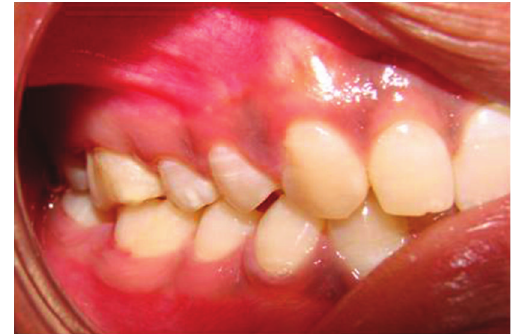
Figure 29: Intraoral periapical radiograph with upper left posterior region at a 2-year followup.